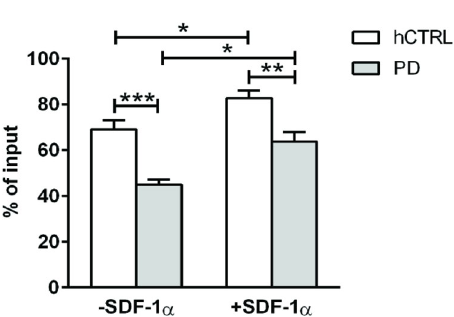
Fig. 1 Decreased motility of PD patients derived primary CD4 + T cells. Transwell migration of primary CD4 + T cells derived from 11 PD patients and 11 age/sex-matched healthy controls with or without SDF-1 α . Transmigration to the lower chamber was assayed using ICAM-1 coated transwells. Cultured CD4 + T cells were allowed to migrate for 1 h at 37 °C to the lower chamber and the number of migrated cells was counted by FACS. The data were obtained from four independent experiments. The percentages of migrated cells to input cells for each group and condition are expressed as the mean percentage ± SEM. Statistical signi fi cance was assessed by using two-way ANOVA followed by Tukey ’ s multiple comparisons test. * p < 0.05, ** p < 0.01, *** p <